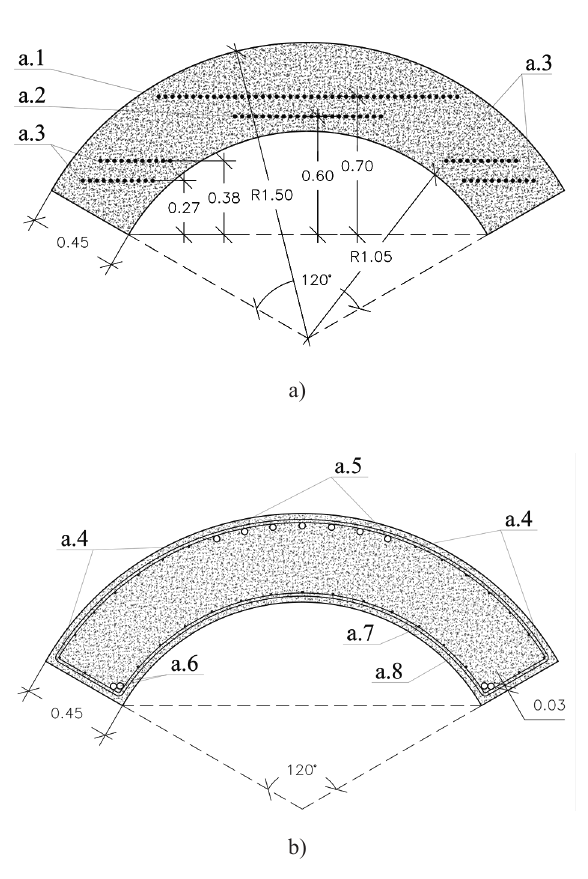
Fig. 3. Reinforcement of the modules